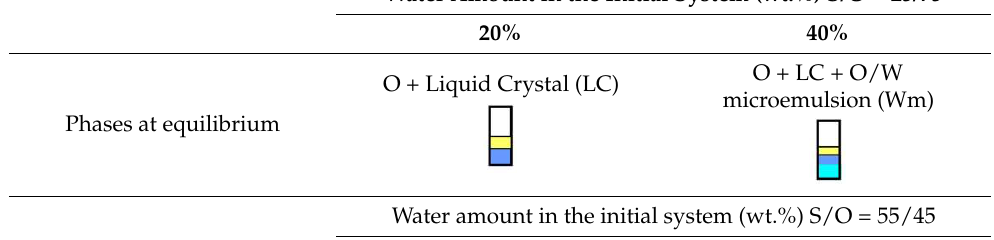
Table 1. Composition of initial concentrated system to be diluted with water to obtain the final NE at 5 wt% surfactant. Dilution lines studied S/O = 25/75, 55/45, and 70/30.